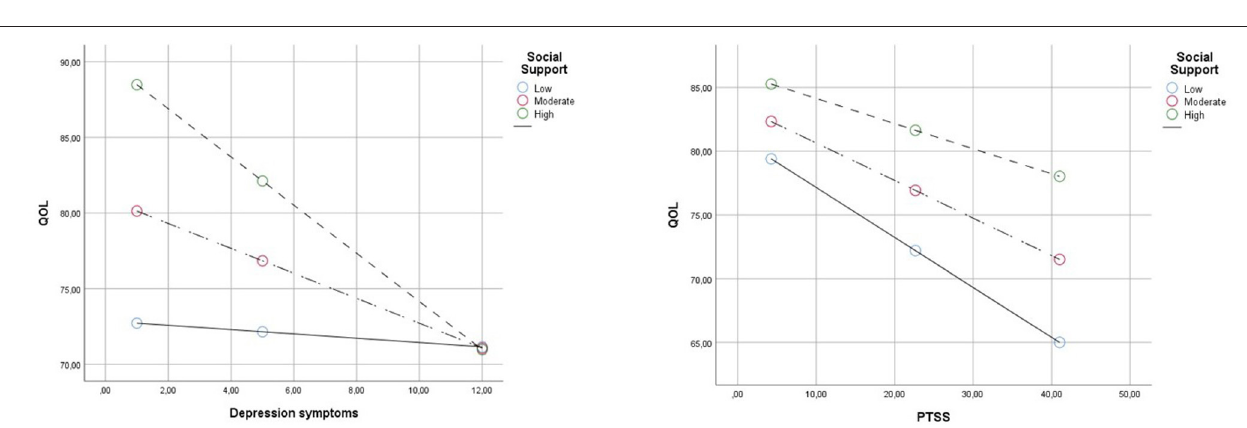
experiences as accumulated through development (43, 44).